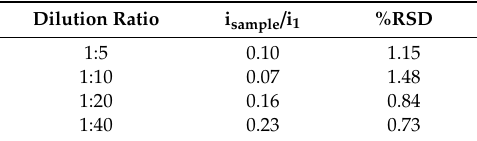
Table 2. Measurements of DA current peak height by varying the dilution ratio of serum samples. The experiments were performed with 50 µ M DA in diluted serum samples at di ff erent ratios with 0.1 M PBS pH 7.0. Each measurement was repeated at least five times using di ff erent sensors.